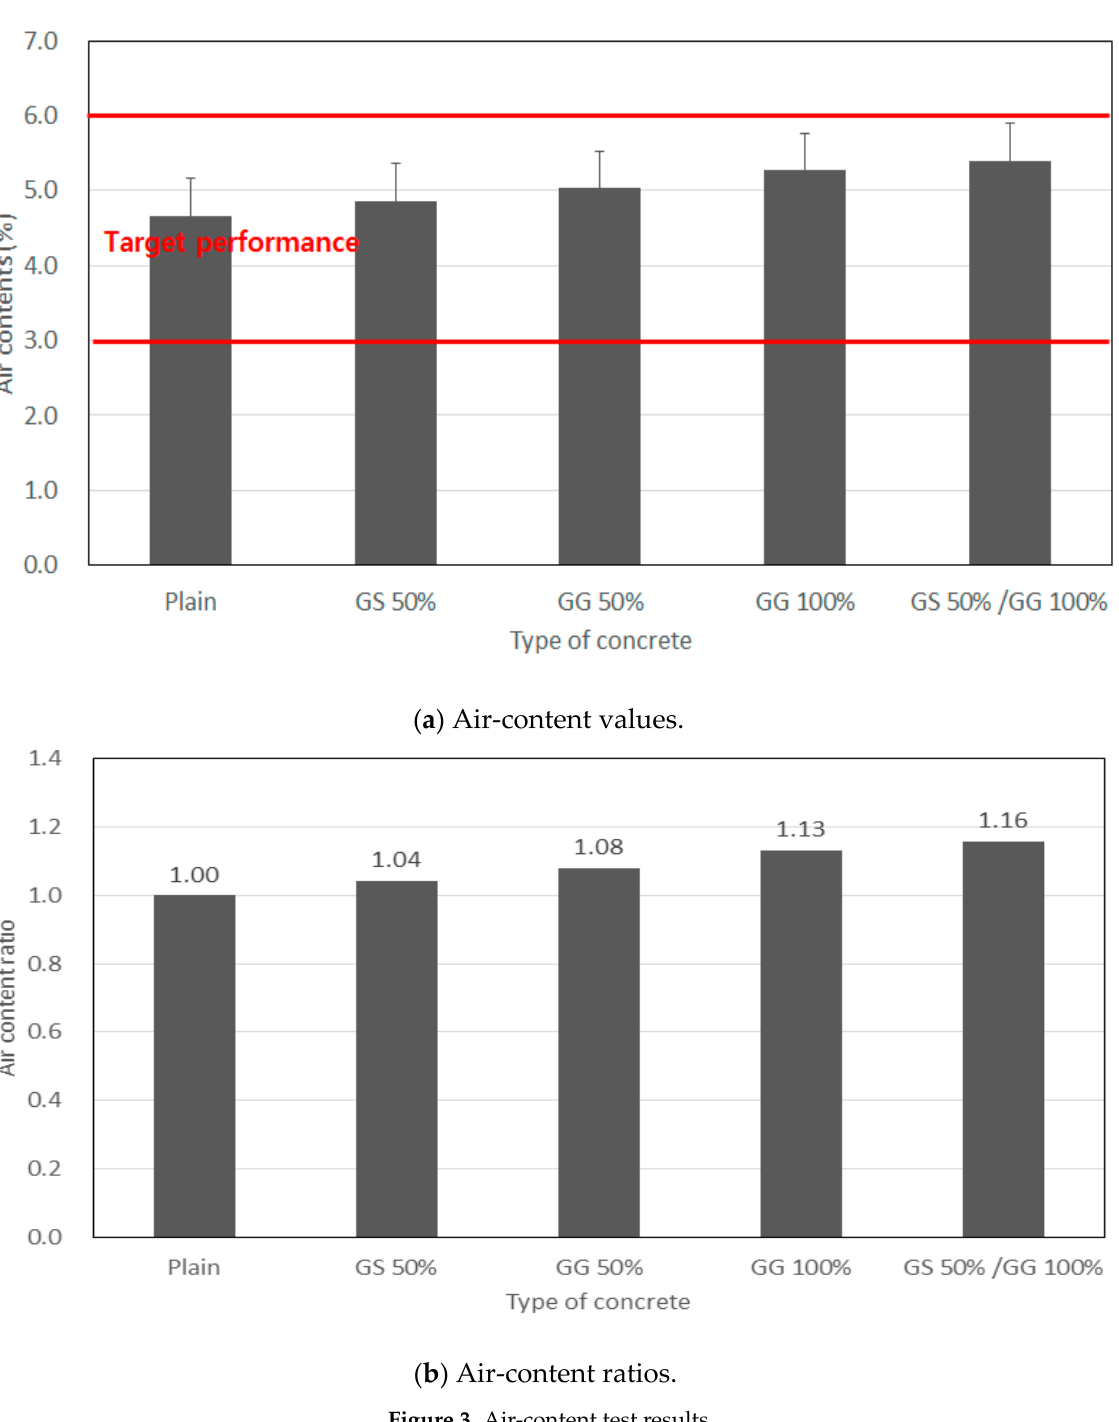
Figure 3. Air-content test results.